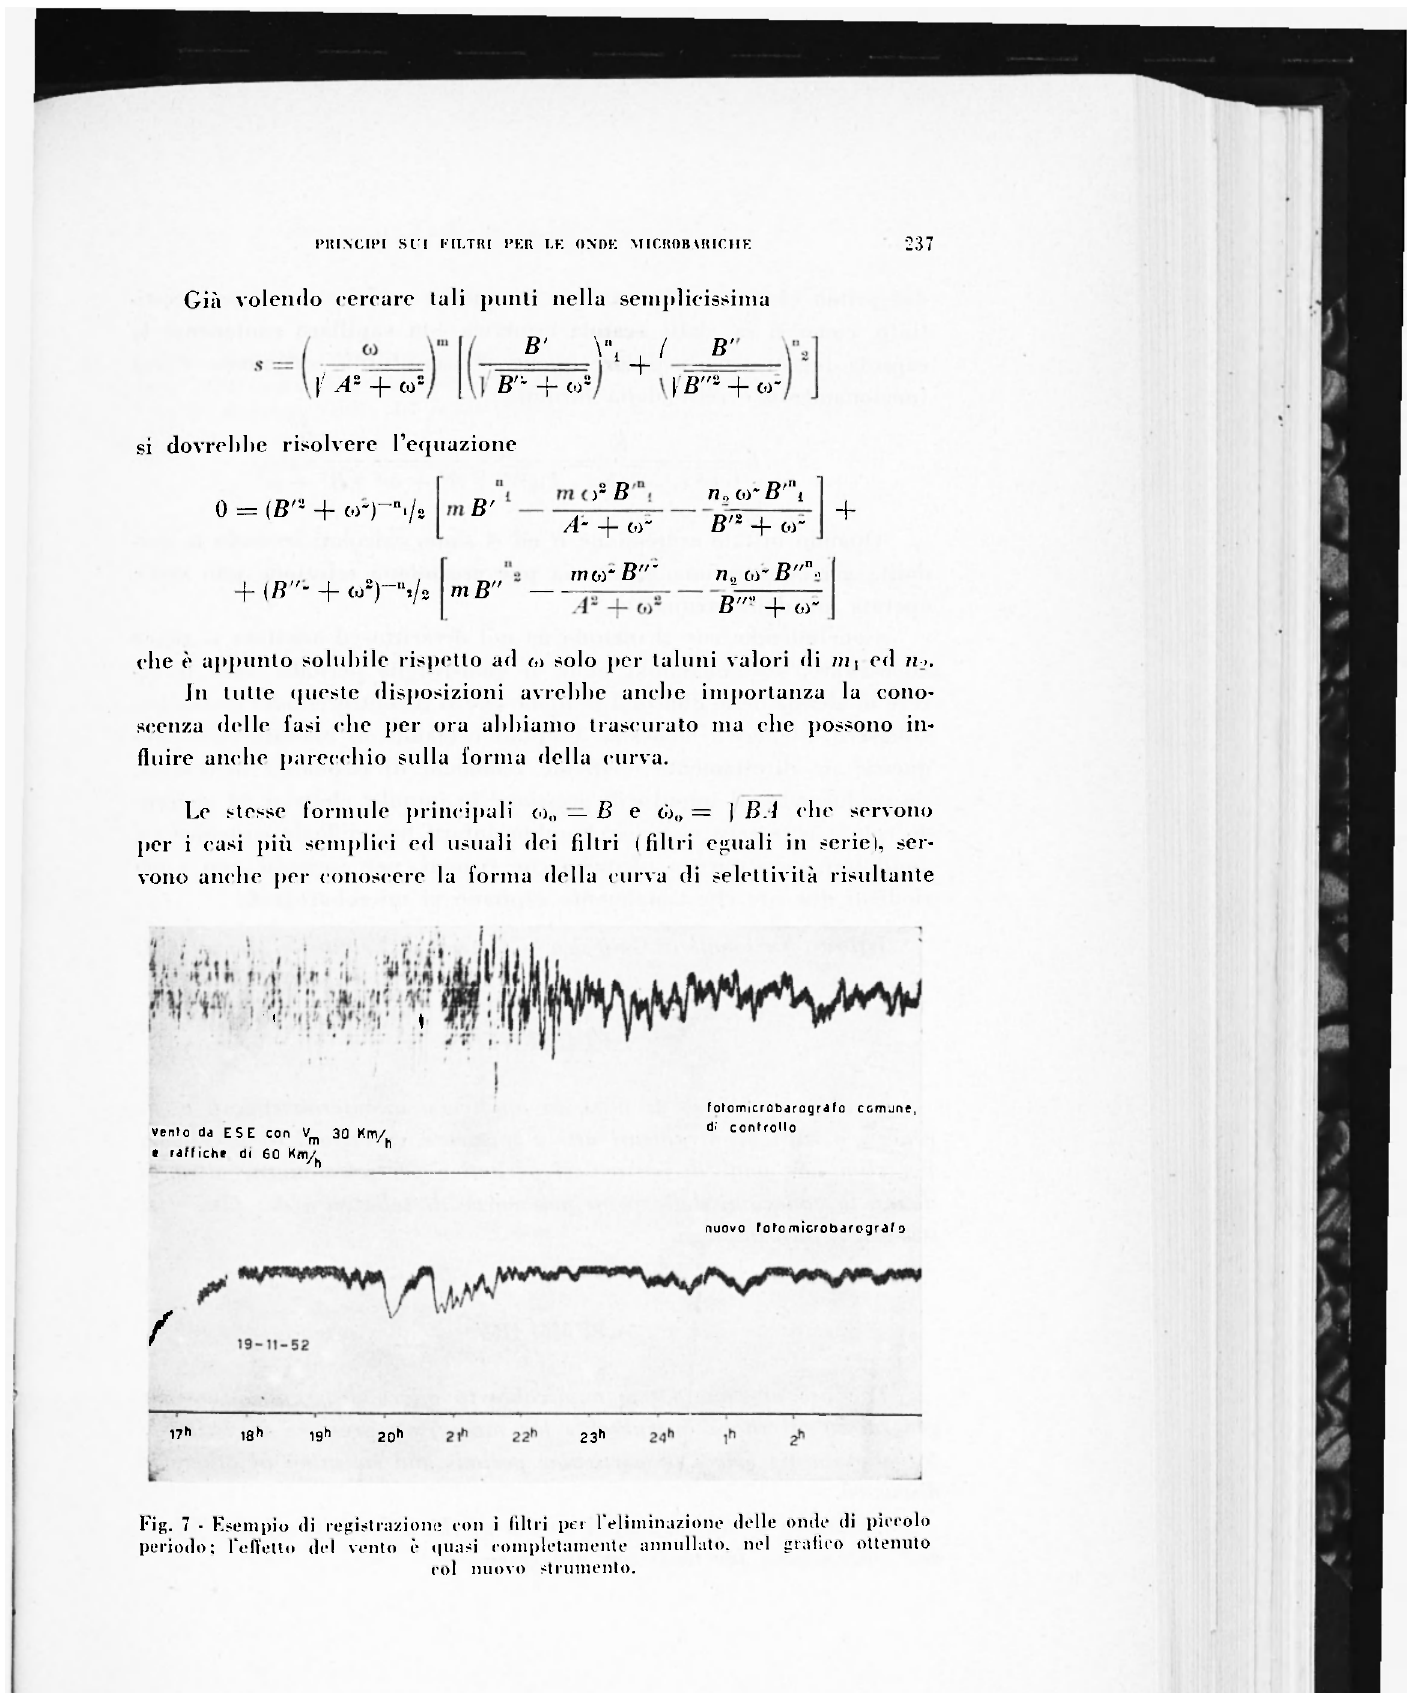
Fig. 7 - Esempio di registrazione con i filtri pei l'eliminazione delle onde di piccolo periodo: l'effetto del vento è quasi completamente annullato, nel grafico ottenuto col nuovo